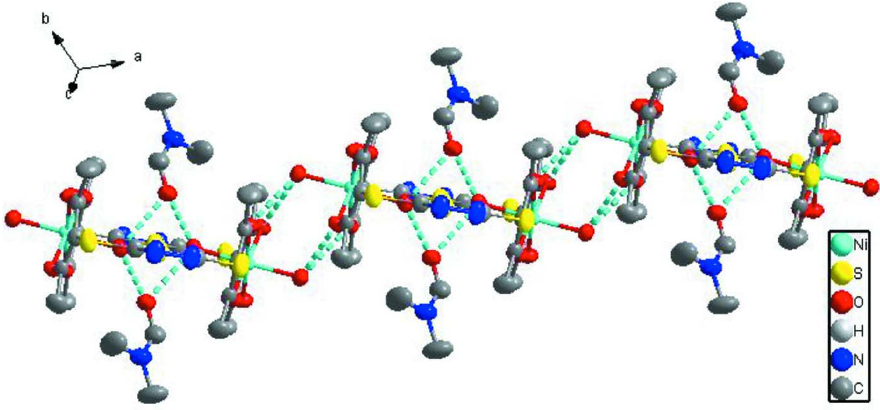
A view of the one-dimensional infinite hydrogen bonds chain. The green lines for hydrogen bonds in the plane, the hydrogen atoms are omited for clarity, the same